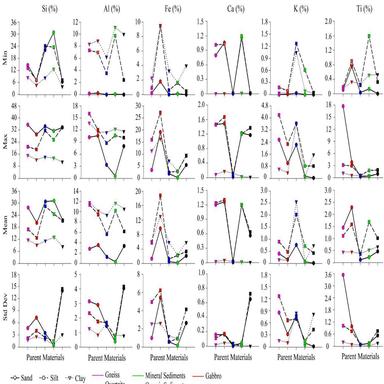
Mean, maximum, minimum, and standard deviation (Std Dev) for Si, Al, Fe, Ca, K, and Ti in the sand, silt, and clay fractions of Brazilian soils derived from gneiss, gabbro, quartzite, mineral sediments, and organic sediments.